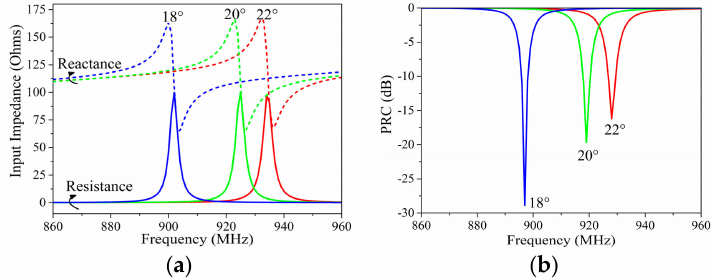
Figure 3. Simulated ( a ) input impedance and ( b ) power reflection coe ffi cient (PRC) results with di ff erent angles of c1